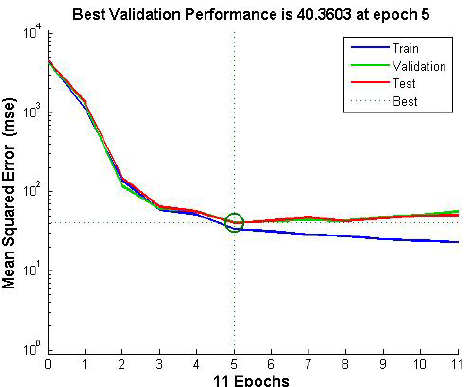
Figure 18. Error histogram.